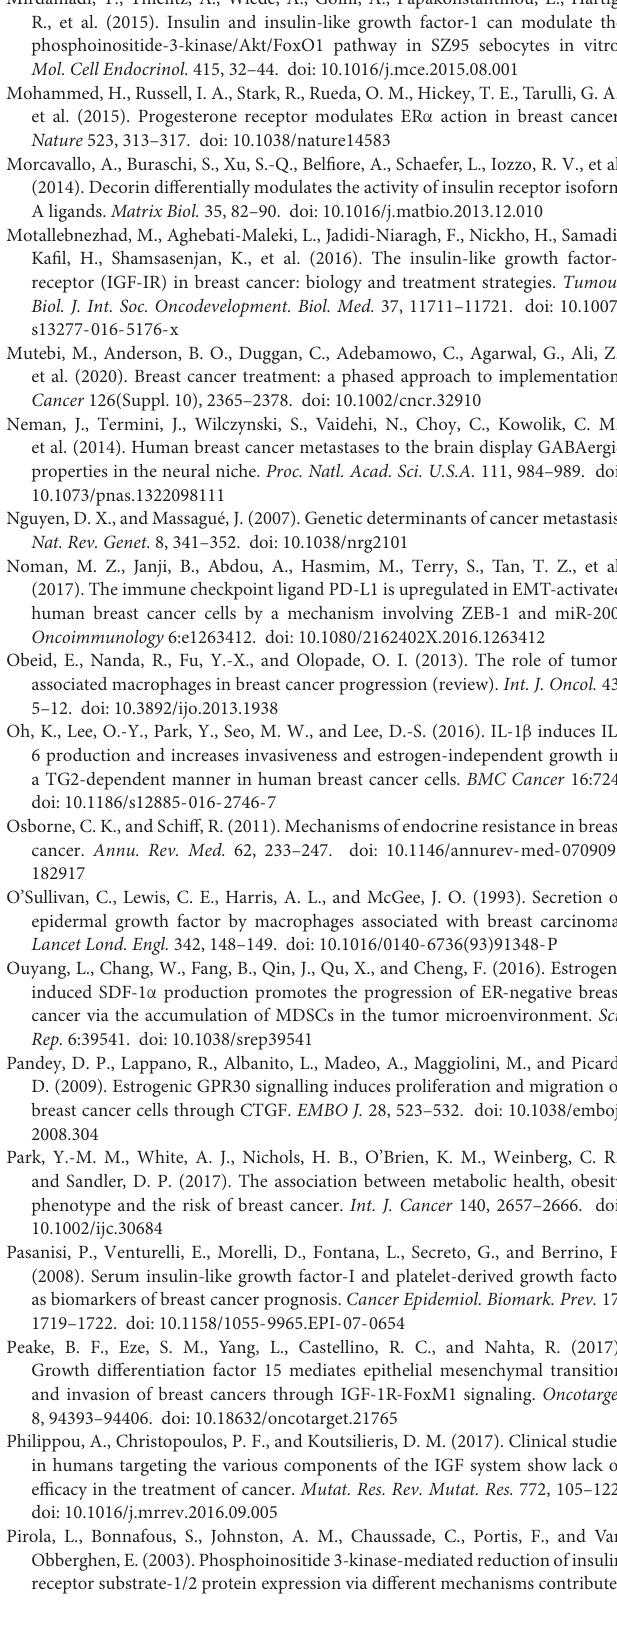
Frontiers in Cell and Developmental Biology |